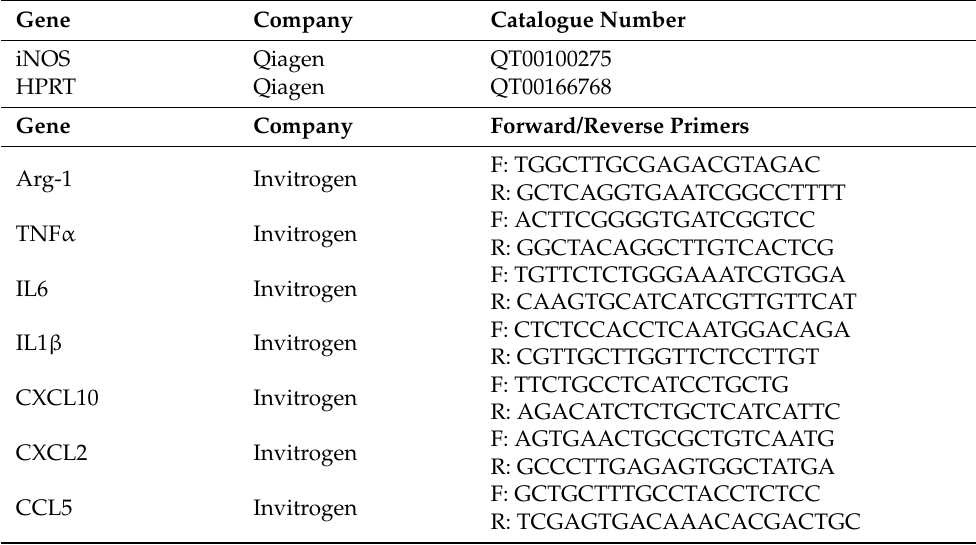
Table 1. Primers used for qPCR experiments during the present study. Gene